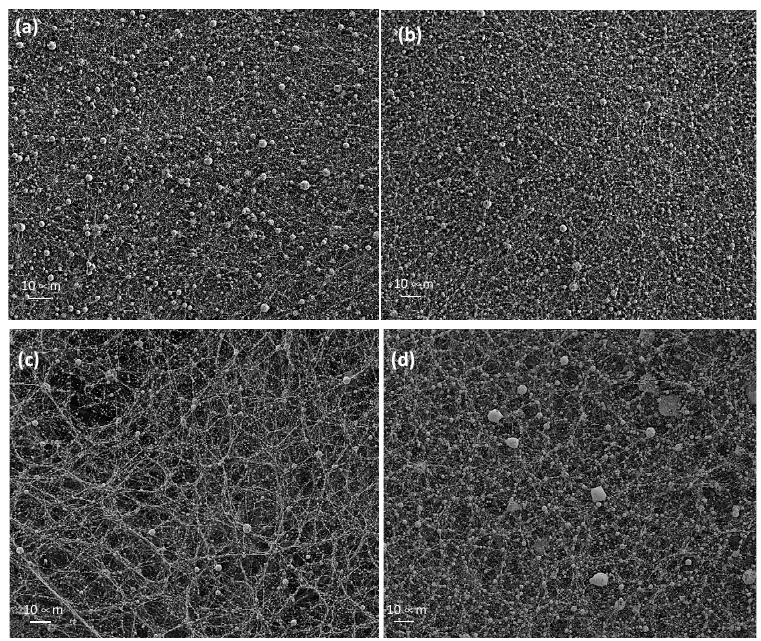
Figure 5. Nanofibers from essential oil emulsions. ( a ) Sage 14 kV; ( b ) sage 20 kV; ( c ) thyme 14 kV; ( d ) thyme 20 kV.